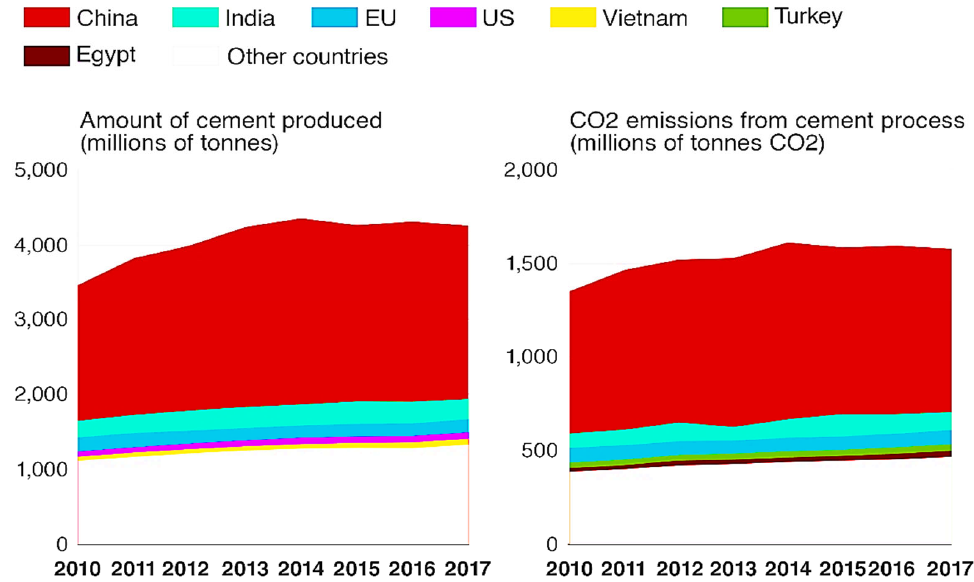
Figure 1. Global cement production volumes and process-related carbon dioxide emissions. Adapted from [33].